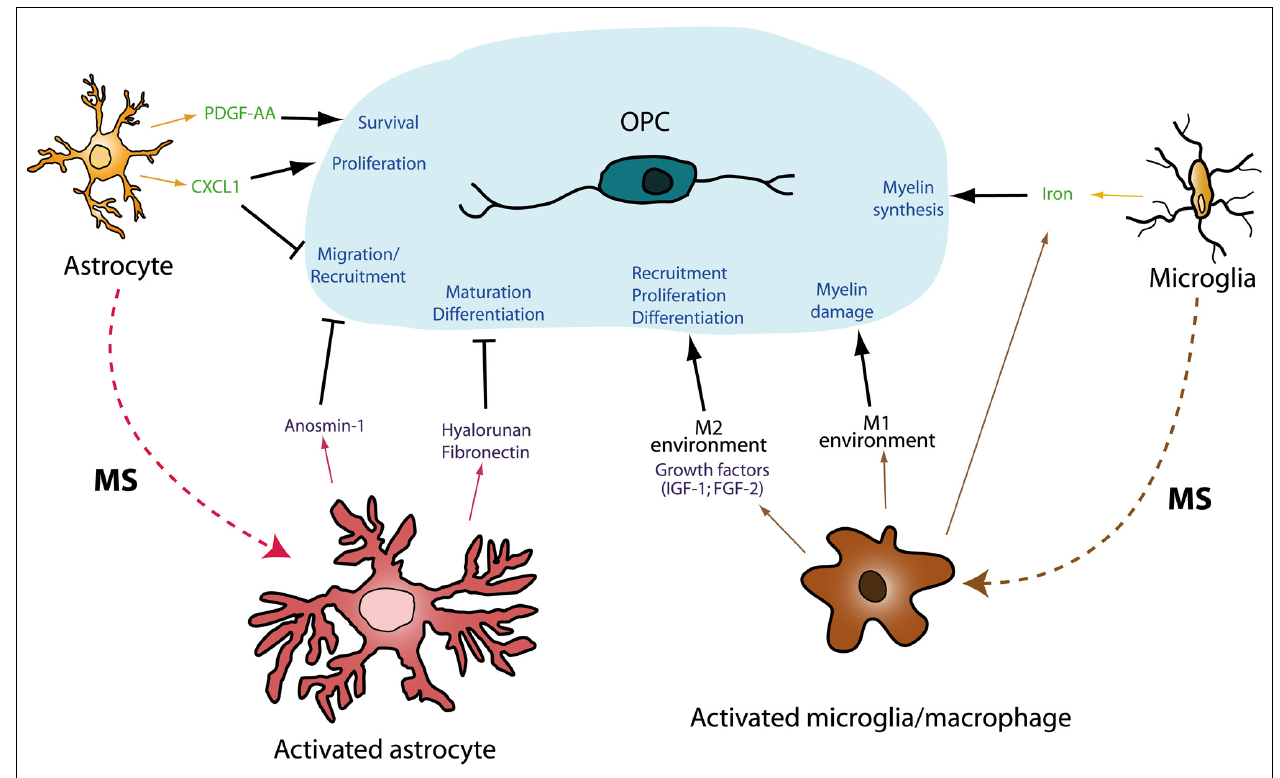
of the oligodendrogliogenesis. Both astrocytes and microglia are able to turn into an activated state in pathological conditions, such as MS.These activated cells can produce molecular factors (purple), which exert their effects on adult OPCs, enhancing (arrows) or impairing (bars) all the processes related to myelin synthesis and